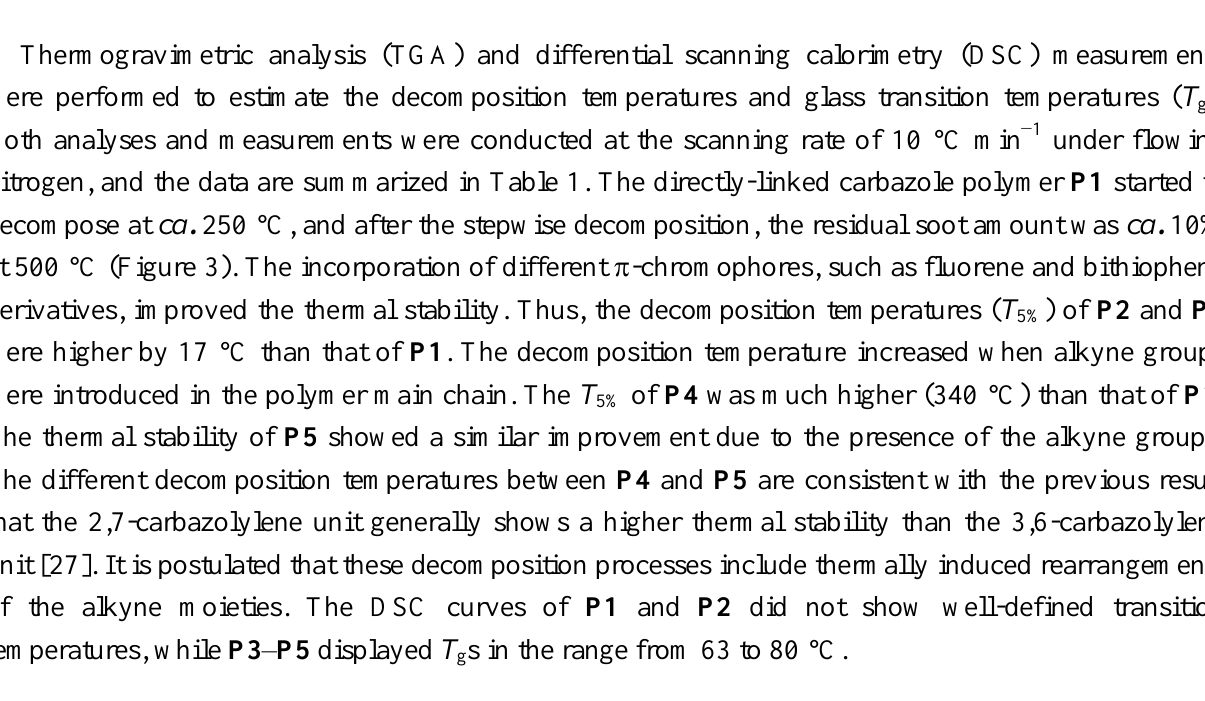
Figure 2. (a) 1 H NMR spectrum of P4 in C